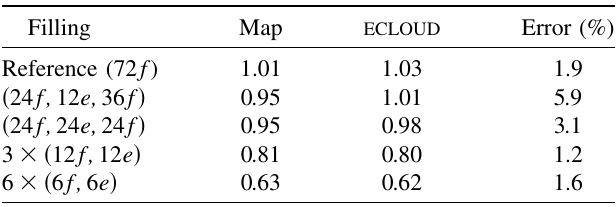
TABLE II. Peak (saturation) value of the (linear) electron- cloud density (in units of (cid:8) 10 11 e (cid:2) =m (cid:9) ) in the LHC arc dipoles for different filling patterns. Comparison between ECLOUD and map results.